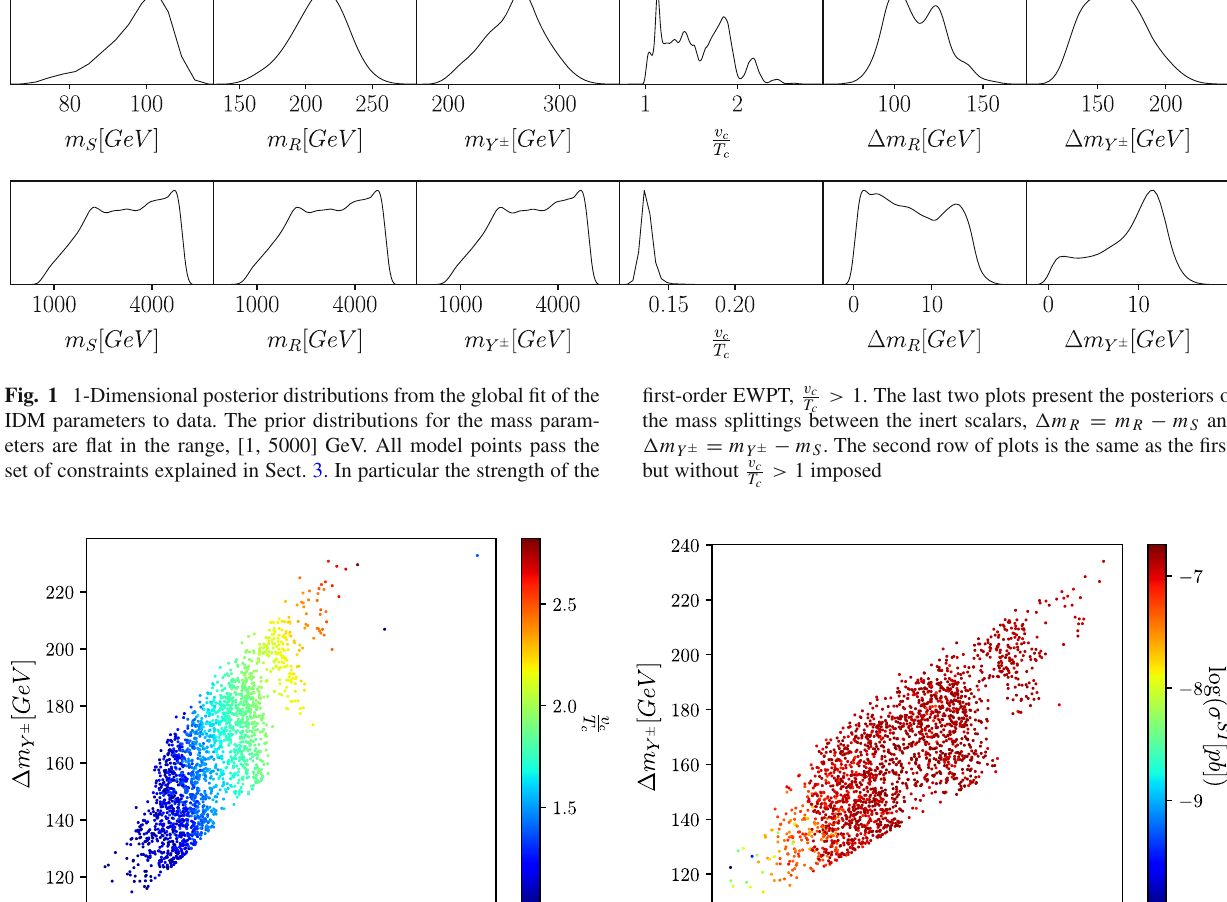
section against nucleons, σ SI . Both quantities show dependence on the mass differences but in opposite directions with respect to the required , and T c respective